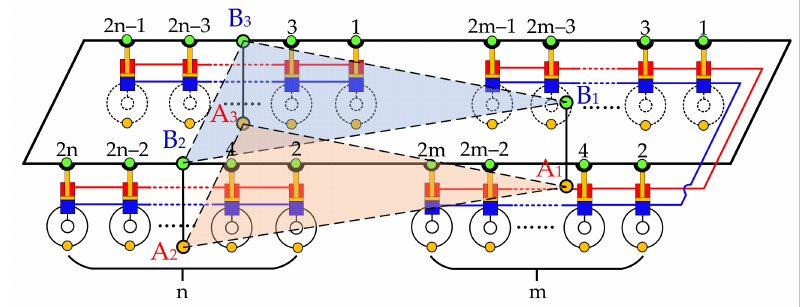
Figure 4. Schematic diagram of equivalent fulcrum of multi-axle vehicle.